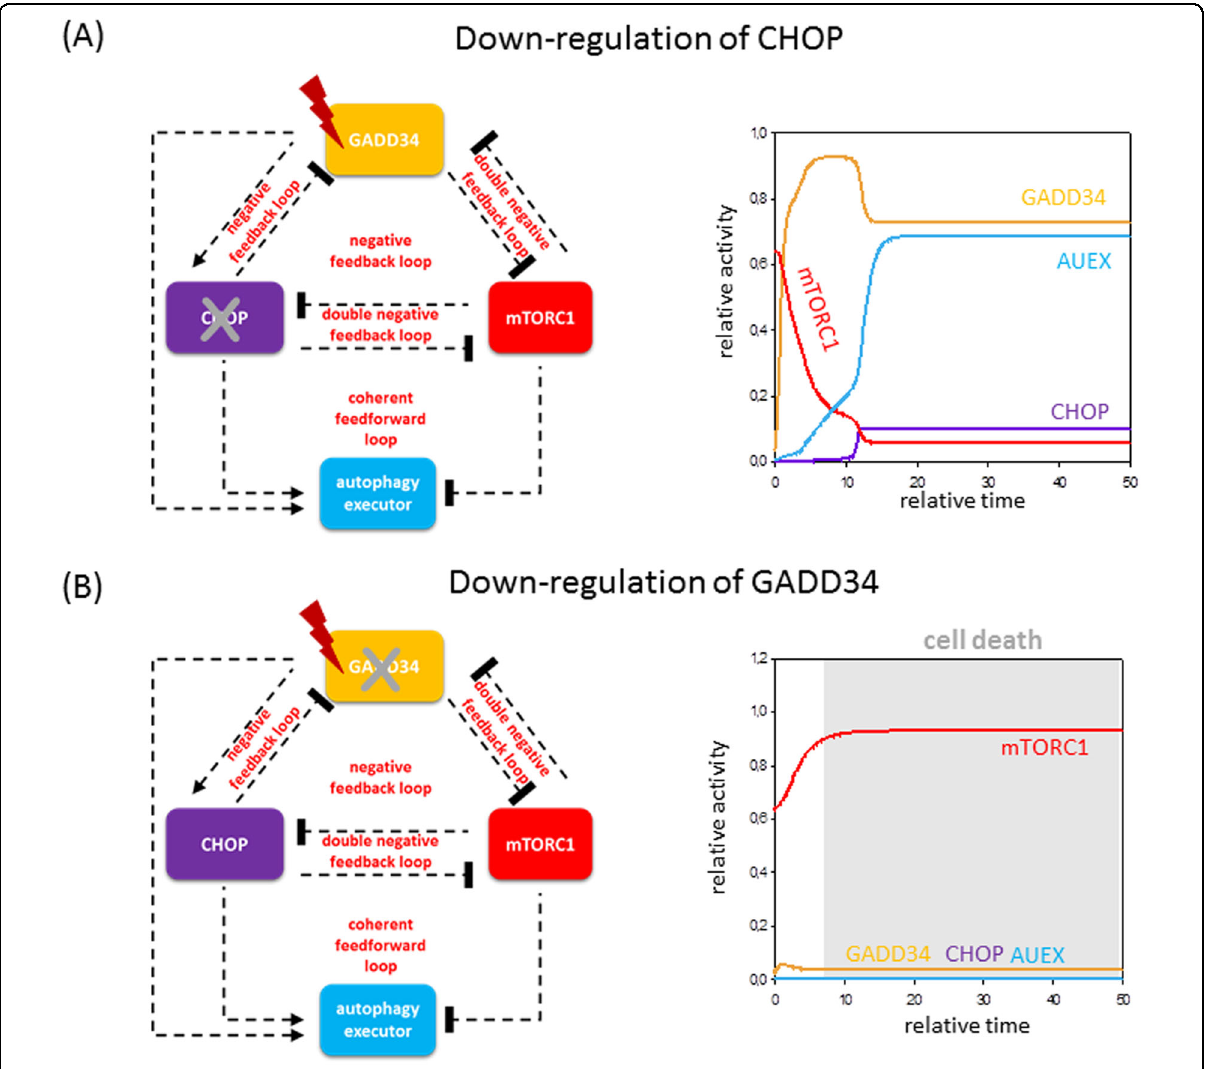
Fig. 4 Both GADD34 and CHOP have important functions at endoplasmic reticulum stress: downregulation of CHOP or GADD34. The computational simulations are determined in the absence of A CHOP and B GADD34 upon excessive levels of cellular stress. The temporal dynamics is simulated with high stress (stress = 9) combined with A CHOP-T = 0.1 or B GADD34-T = 0.1. Grey background refers to possible cell death. For details about the codes and software used for simulations, see the Supplementary